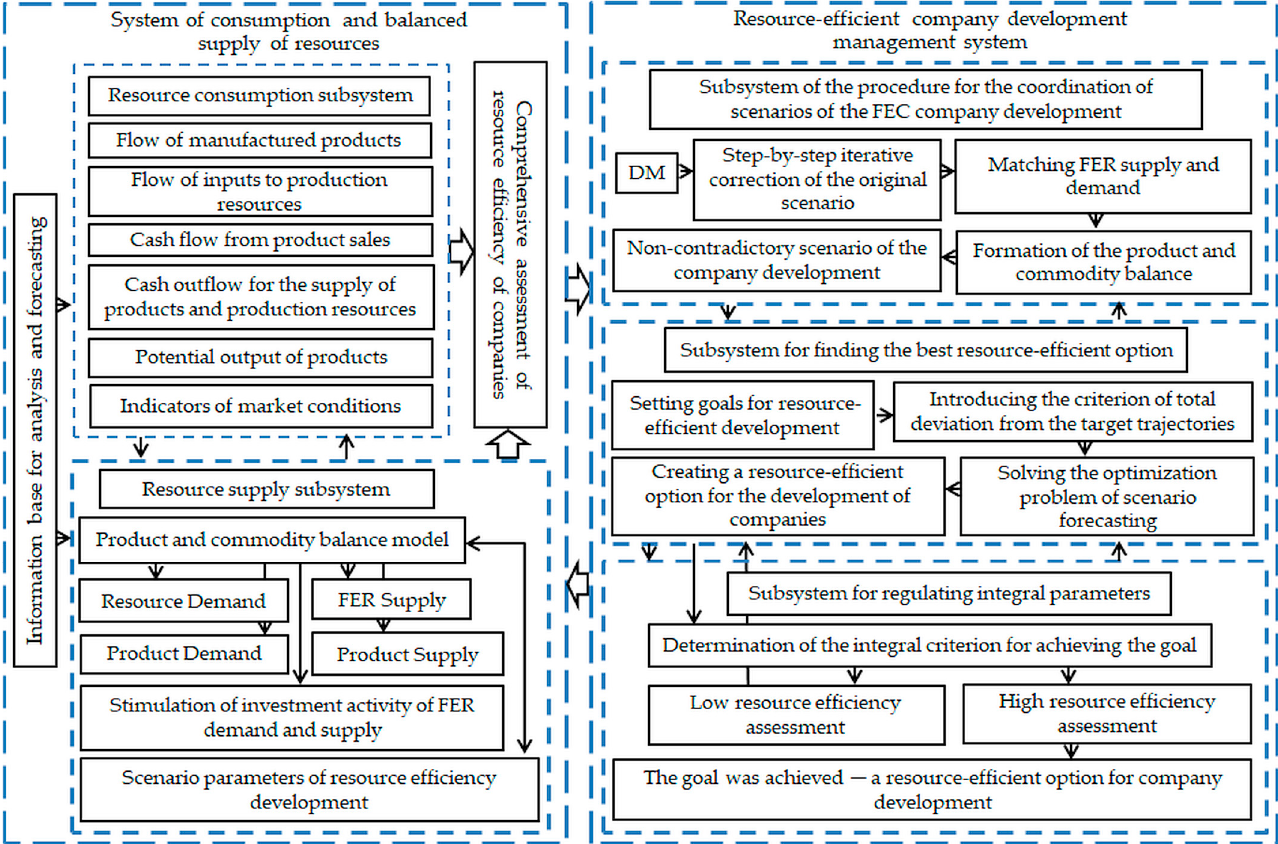
Figure 2. The mechanism for efficient resource management in fuel and power companies. Abbreviations used: FER—fuel and energy resources; DM—decision maker.